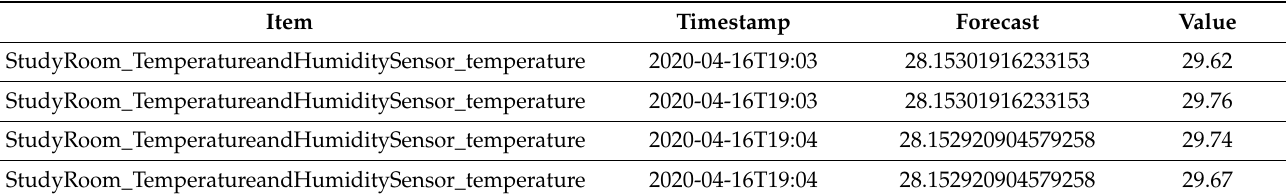
Table 5. Sample streaming comparison for the temperature parameter.